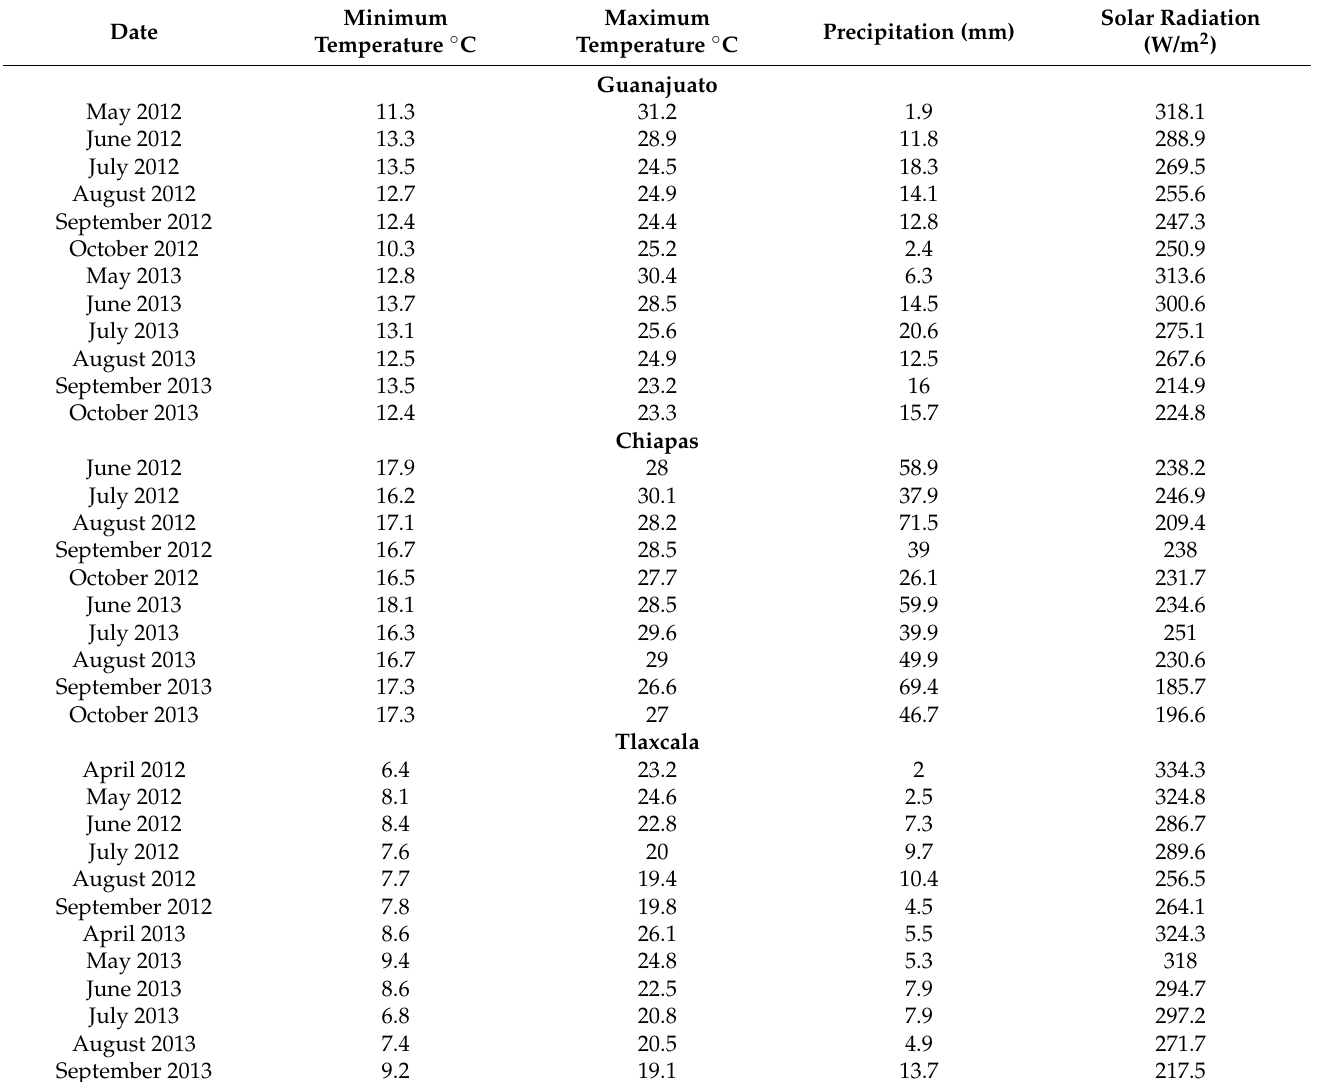
Table 3. Mean minimum and maximum temperatures, precipitation, and solar radiation occurring during the crop cycles in the experiments in Guanajuato, Chiapas, and Tlaxcala, Mexico.